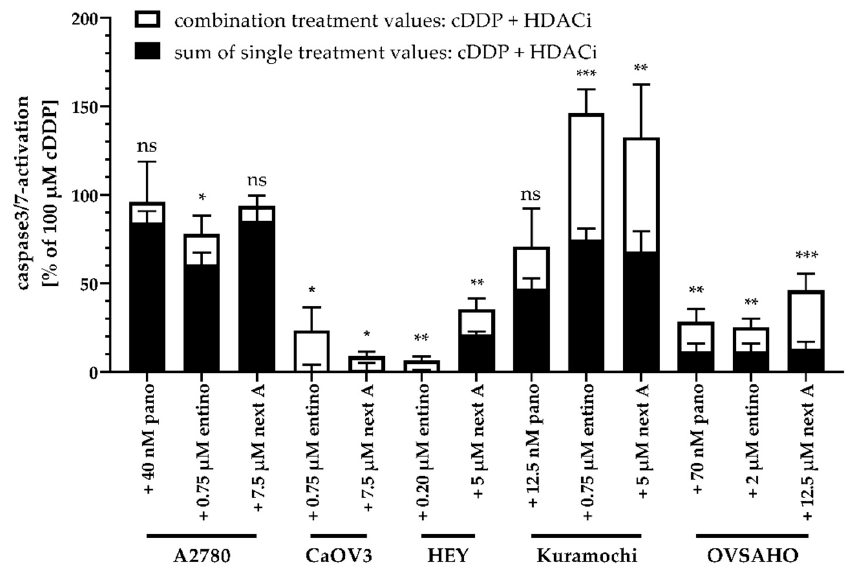
Figure 8. Synergistic effects of caspase3/7-activation upon combination treatment of HDACi and cisplatin. The sum of single treatment effects (HDACi, cisplatin) are shown in black bars. The extended white bars show the difference (superadditive (= synergistic) part) between the sum of single treatment effects and the effect of combination treatments. Results are shown for treatments significantly enhancing caspase3/7-activation (Figure 7). Before calculation, values were normalized to the effect of 100 µM cDDP and vehicle treated control was subtracted. Data shown are mean ± SD. Statistical analysis was performed using t-test. Levels of significance: ns ( p > 0.05); * ( p ≤ 0.05); ** ( p ≤ 0.01); *** ( p ≤ 0.001).